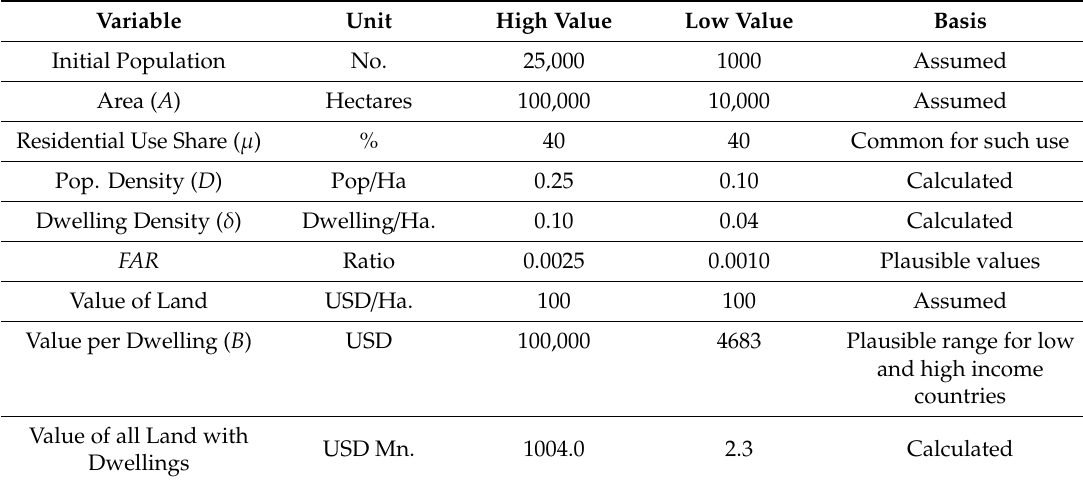
Table 1. Baseline initial values for land services for high and low value